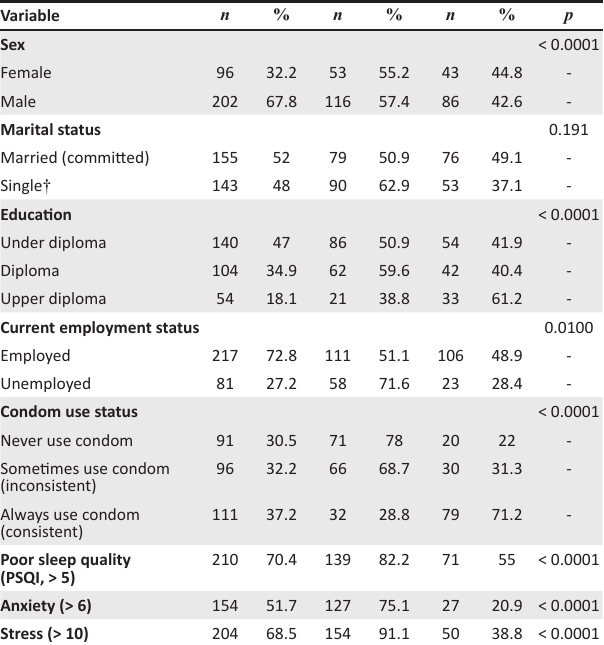
TABLE 1b: Demographic characteristics of the depressed and non-depressed participants.